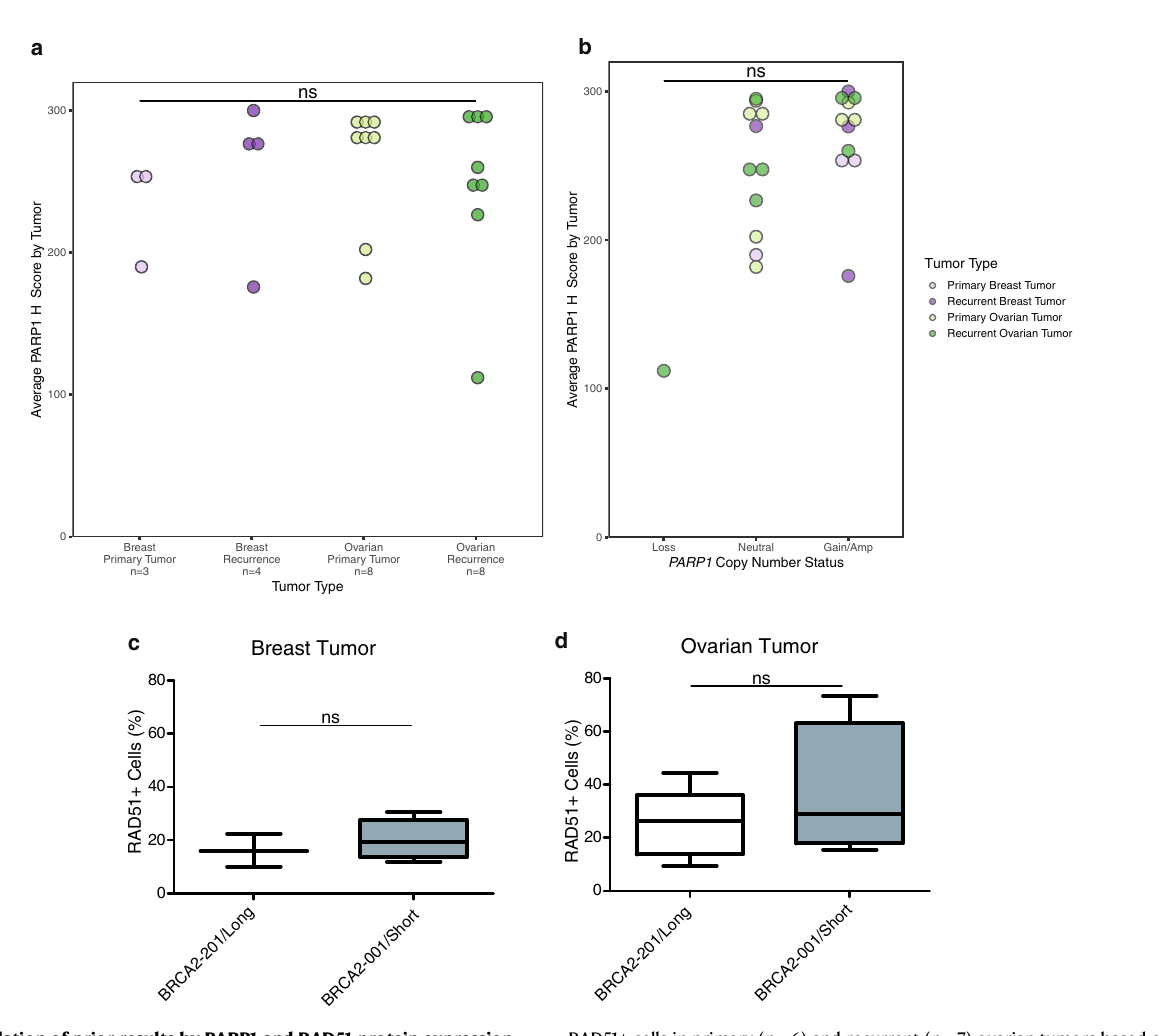
RAD51+ cells in primary ( n =6) and recurrent ( n =7) ovarian tumors based on BRCA2 transcript usage. For c and d , boxplot elements are as follows: median, center line; box limits, fi rst and third quartiles (spanning the IQR, interquartile range);whiskers,1.5xIQRineachdirection;outliersplottedindividually.Groupwise differences in c and d were assessed by two-sided Wilcoxon rank sum test ( α =0.05).TumorswithoutRNA-seqdata( n =2)orexpressingboth BRCA2 isoforms ( n =1) were excluded from this